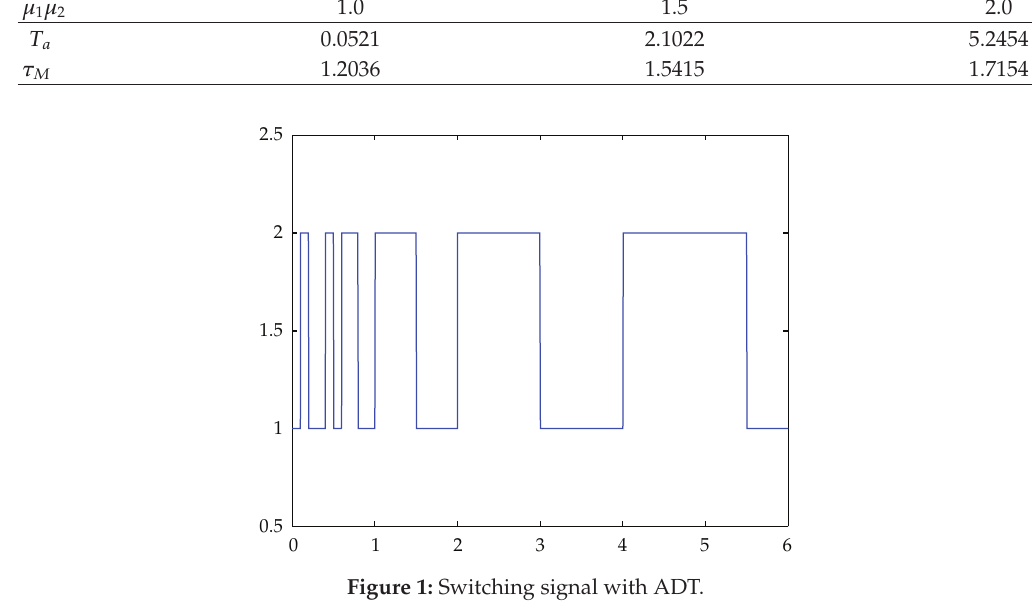
Figure 1: Switching signal with